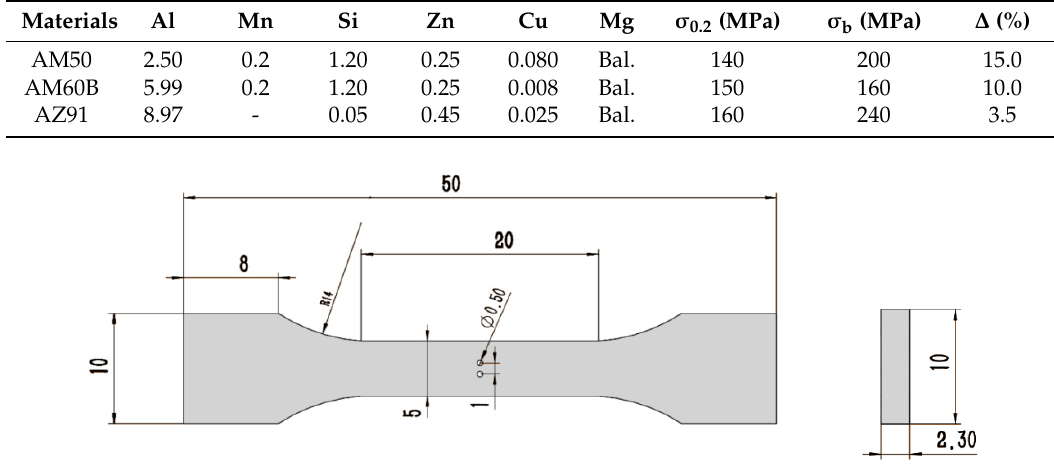
Figure 1. Schematic illustration and size of the specimen; all dimensions’ unit: mm.